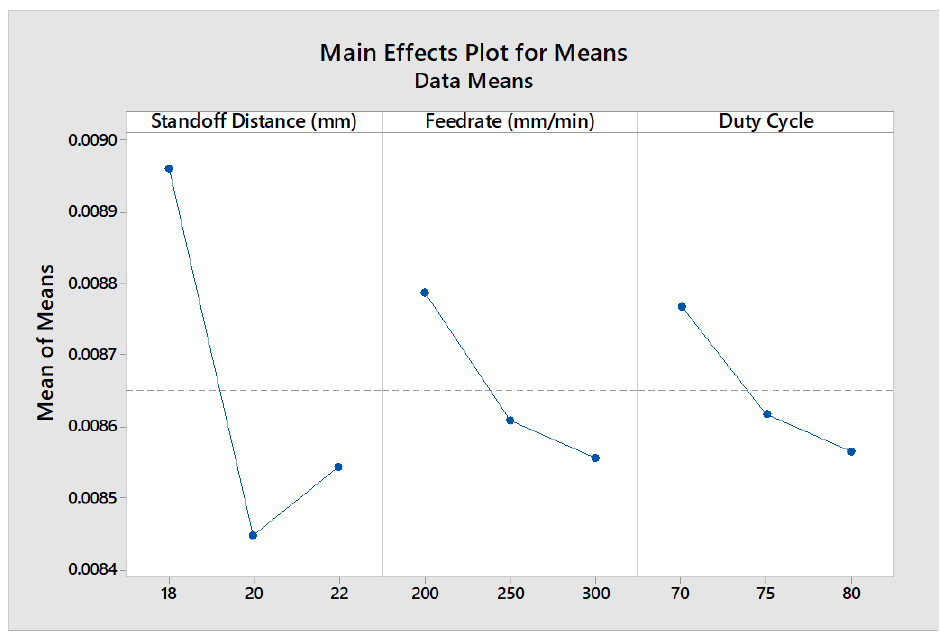
Figure 9. MEP of process factors on MRR. Table 4. Calculated values for weight and